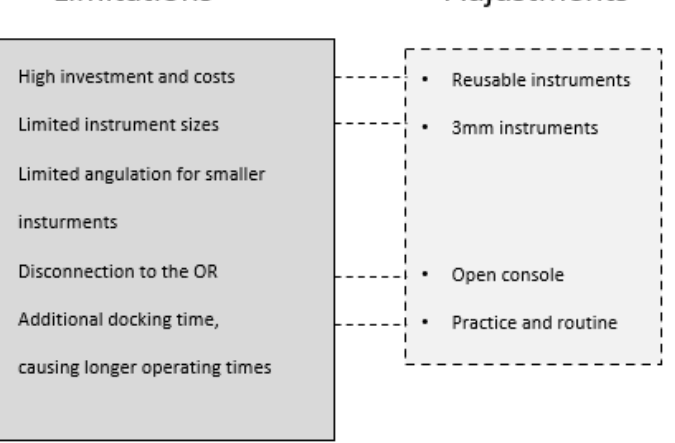
Figure 2. Summarized advantages, limitations and adjustments of robotically assisted surgery in children.